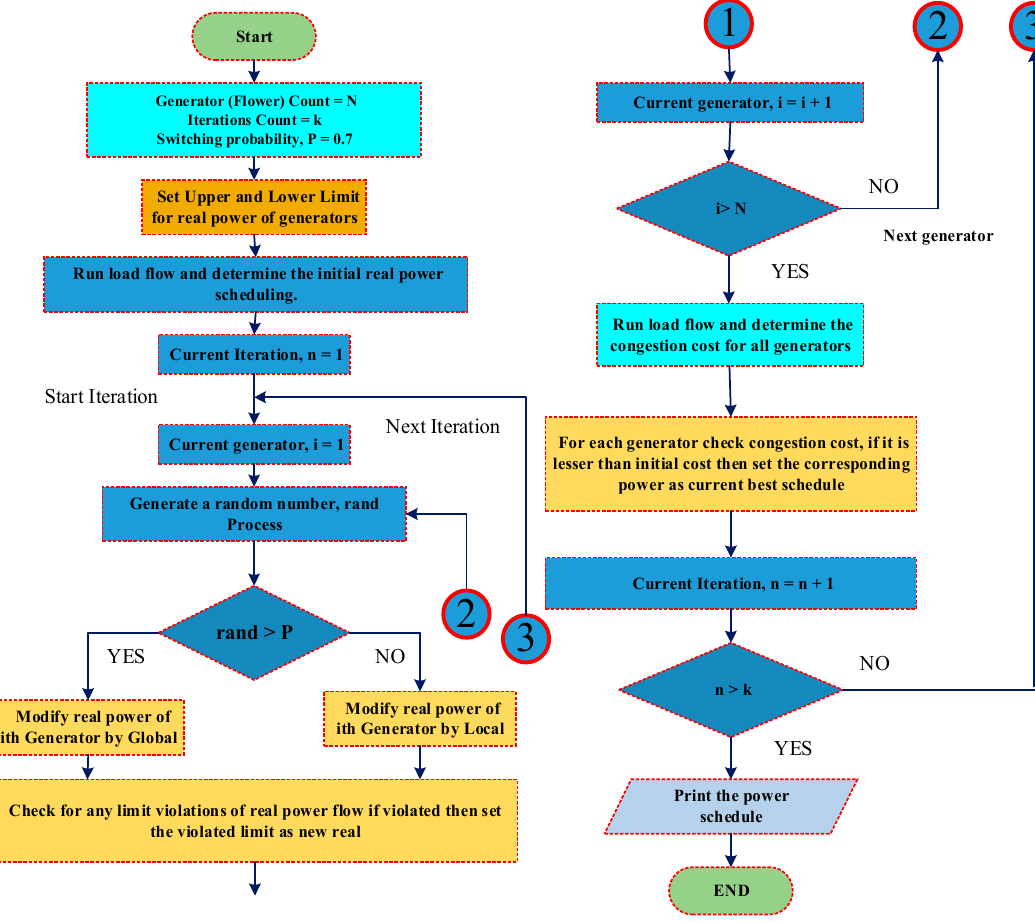
Figure 3. Implementation of FPA for congestion management.